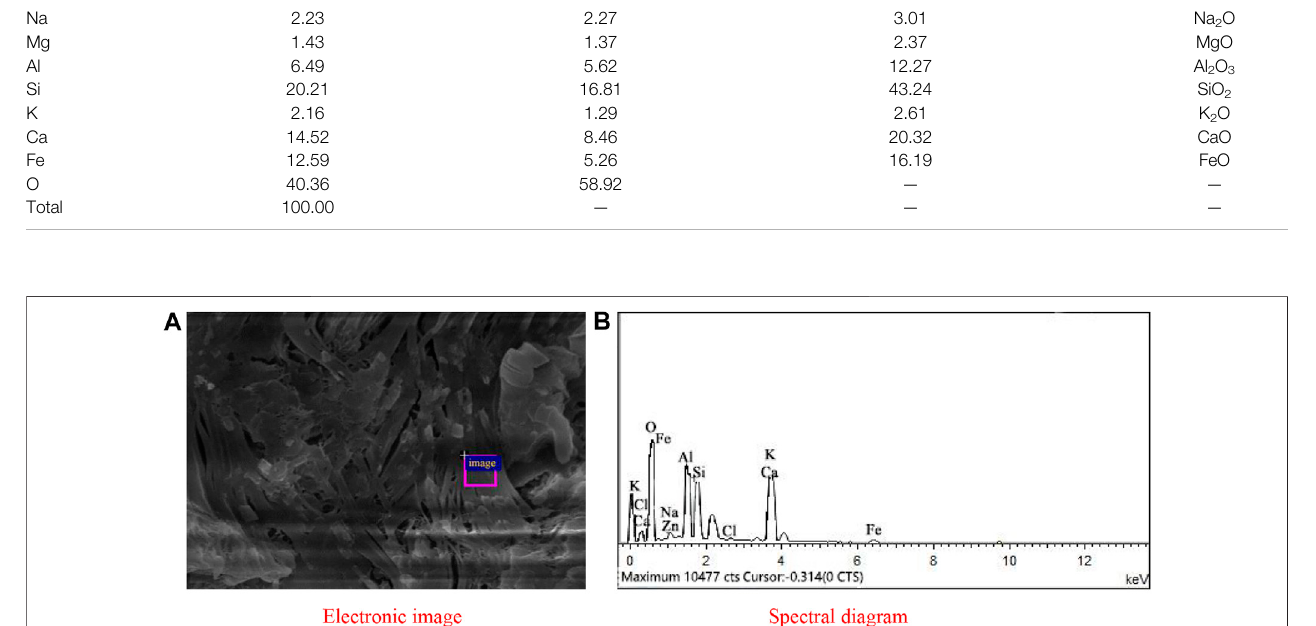
FIGURE 12 | EDS of C-A-H or C-A-S-H from the one-part geopolymer-stabilized soil sample with 90% GGBFS and 10% FA at 4.64 mol/L NH solution: (A) Electronic image; (B) Spectral diagram.